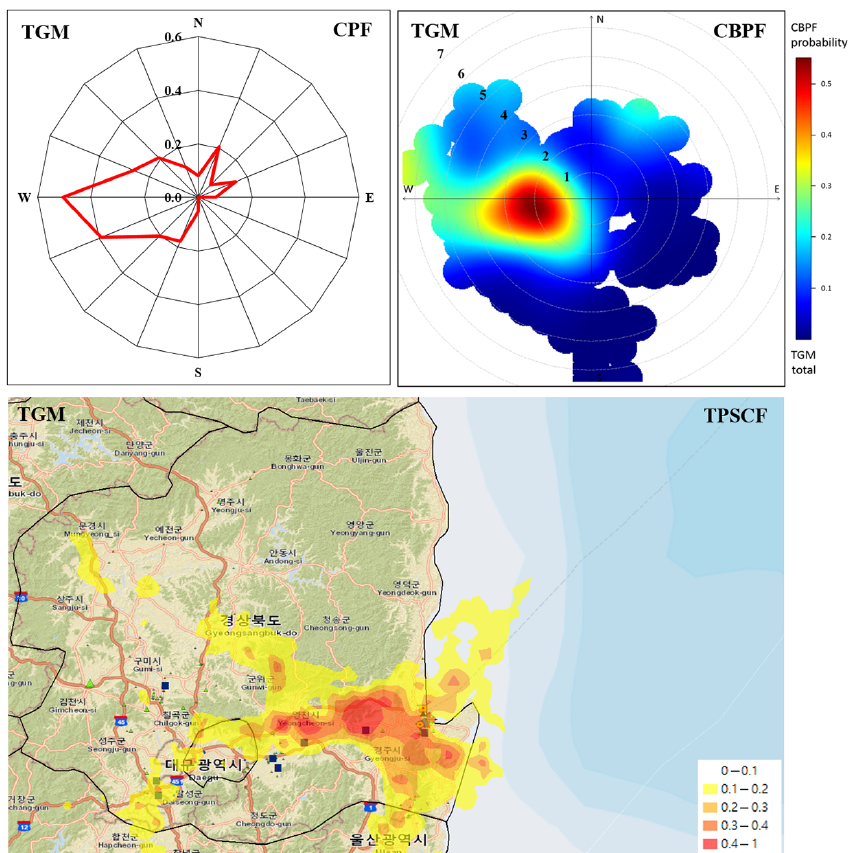
Figure 4. CPF, CBPF and TPSCF plots for TGM higher-than-average concentration. The radial axes of CPF and CBPF are the probability and the wind speed (ms − 1 ) ,